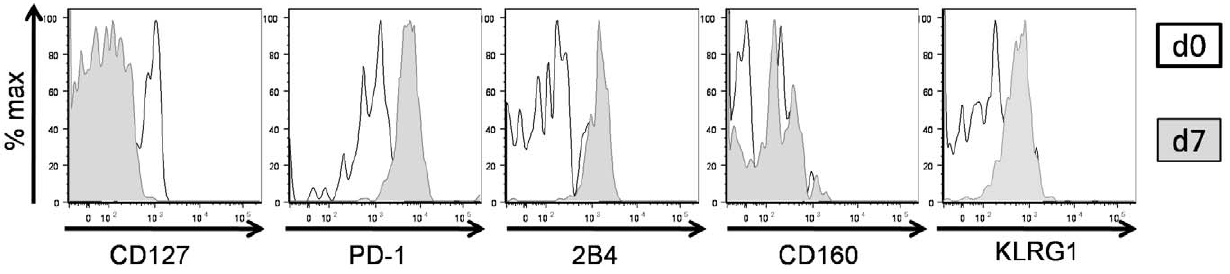
Figure 9. Upregulation of inhibitory receptor expression on CD127hi cells upon antigen stimulation. Comparison of CD127, PD-1, 2B4, CD160 and KLRG1 expression on HCV-specific CD8 + T cells prior and 7 days post stimulation are shown by overlay histograms for representative patient 24 (total n=14).